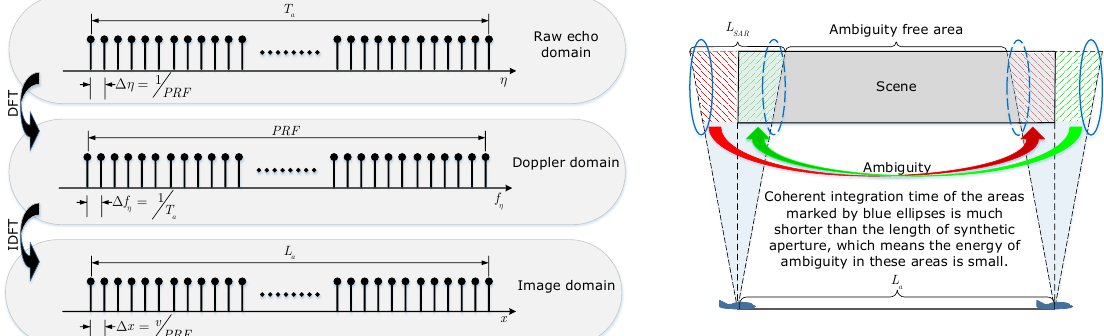
Ambiguity Coherent integration time of the areas marked by blue ellipses is much shorter than the length of synthetic aperture, which means the energy of ambiguity in these areas is small.